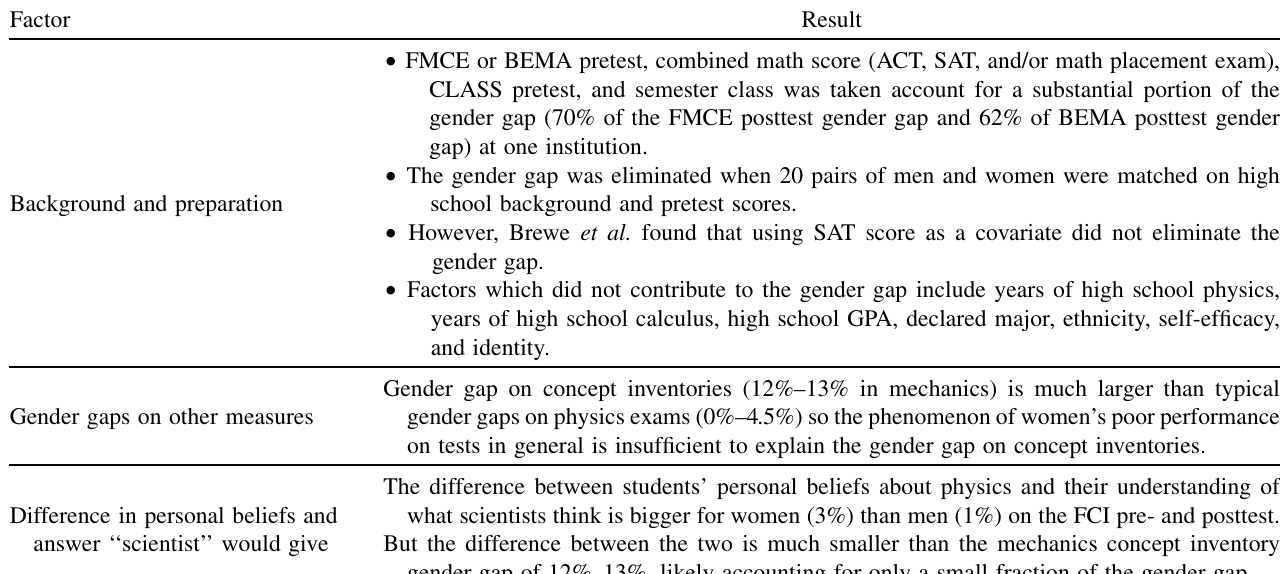
TABLE II. Summary of findings on factors that may influence the gender gap on concept inventories in